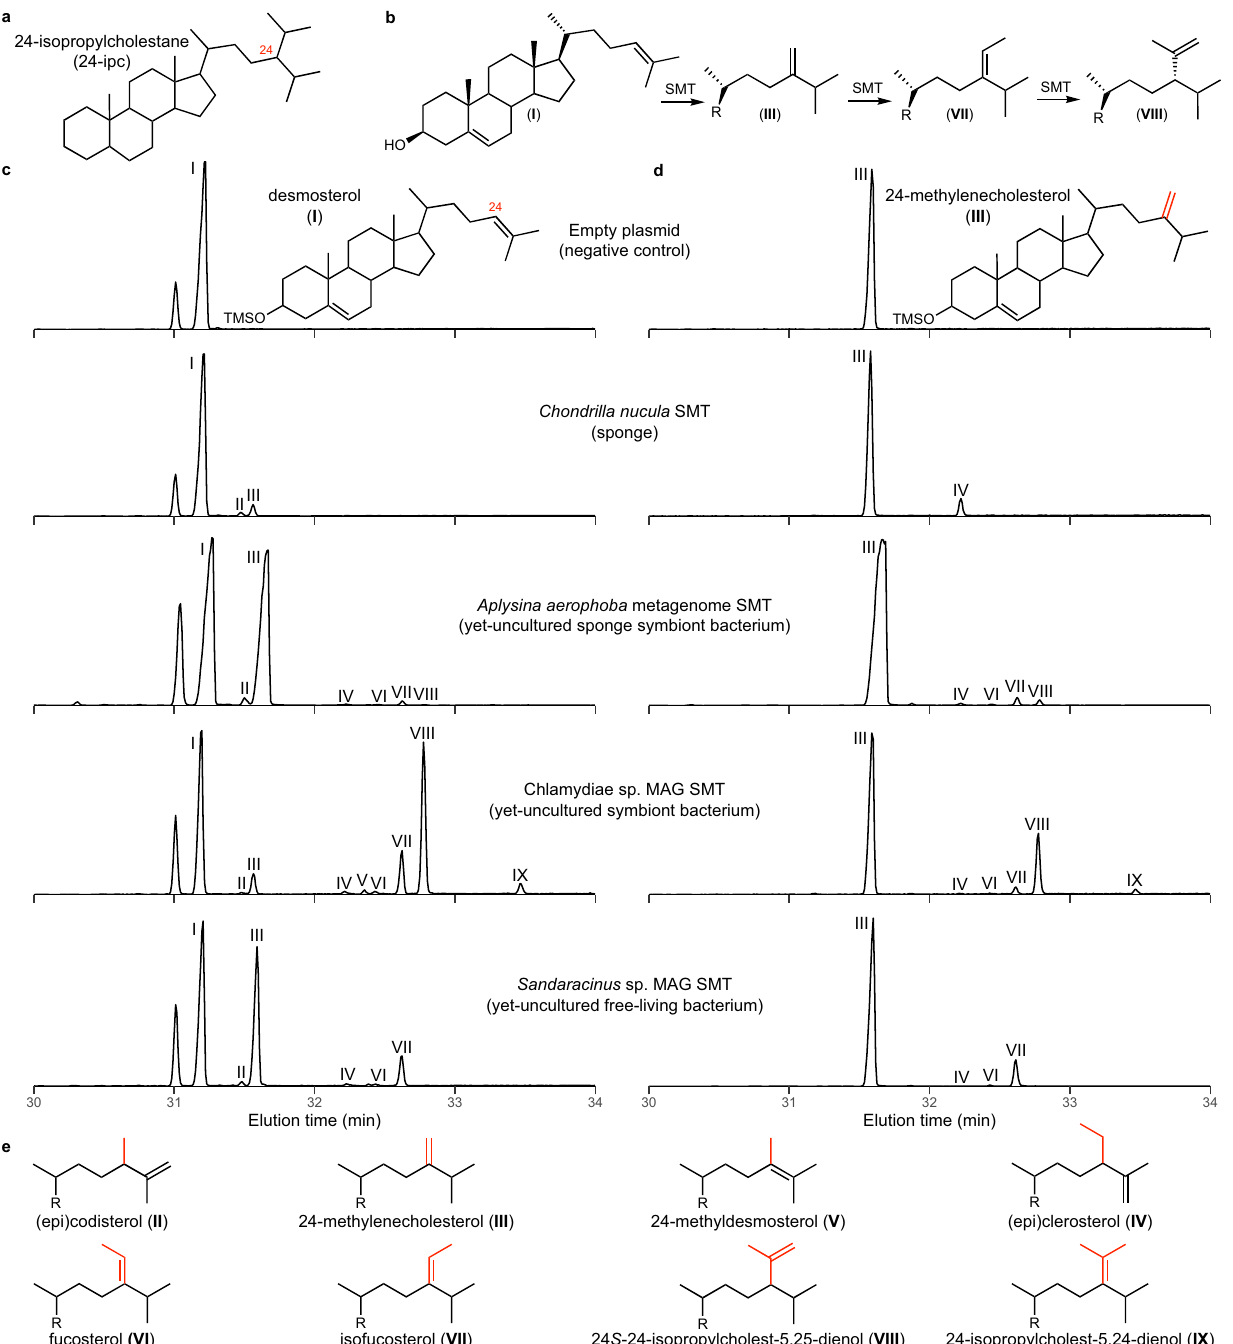
Fig. 1 | Sterol methyltransferases from sponges and yet-uncultured bacteria perform multiple side-chain methylations in vitro. a Structure of the sponge biomarker24-isopropylcholestane. b Predominantpathwayto24-isopropylsterols by bacterial sterol methyltransferases (SMTs). c Representative extracted ion chromatograms ( m/z 456, 470, 484, 498) of total lipid extracts from in vitro reac- tions performedwith desmosterol and E. coli lysates containing anempty plasmid, an SMT identi fi ed in a transcriptome of the demosponge Chondrilla nucula , a bacterial SMT identi fi ed in a metagenome from the demosponge Aplysina aerophoba , a bacterial SMT identi fi ed in a freshwater metagenome-assembled